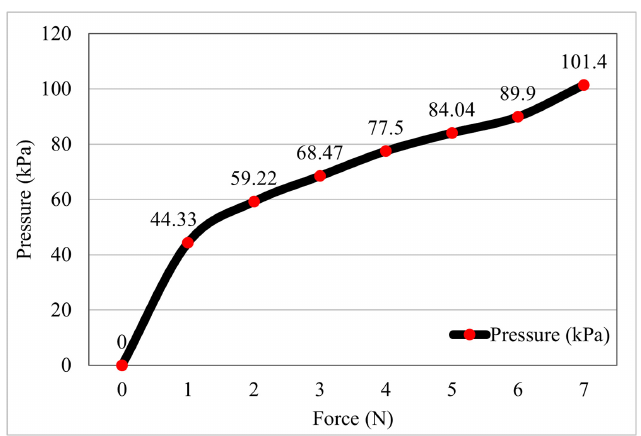
Figure 10. Force versus air pressure obtained from the